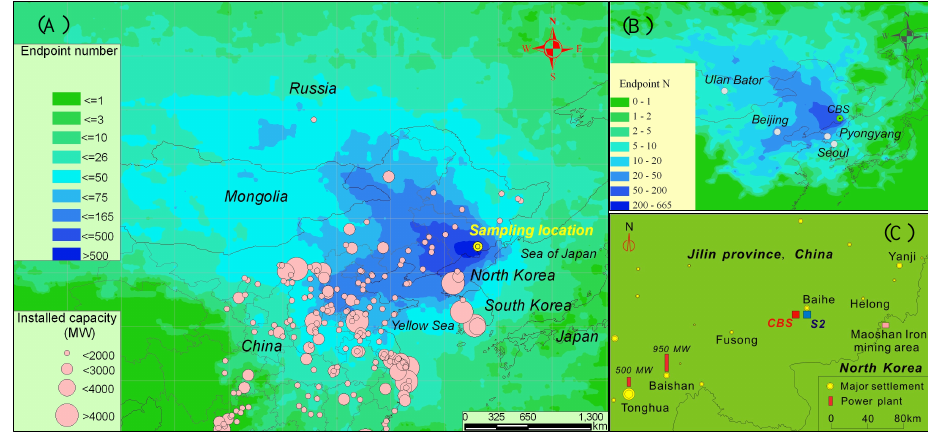
Fig. 1. Map showing (A) location of the sampling site CBS, large coal-fired power plants and air masses endpoints at CBS during the year of October 2008–October 2010; (B) air masses endpoints at the site of S2 during Aug. 2005–July 2006; and (C) locations of CBS and S2 as well as regional major settlements and large point sources in Mt. Changbai